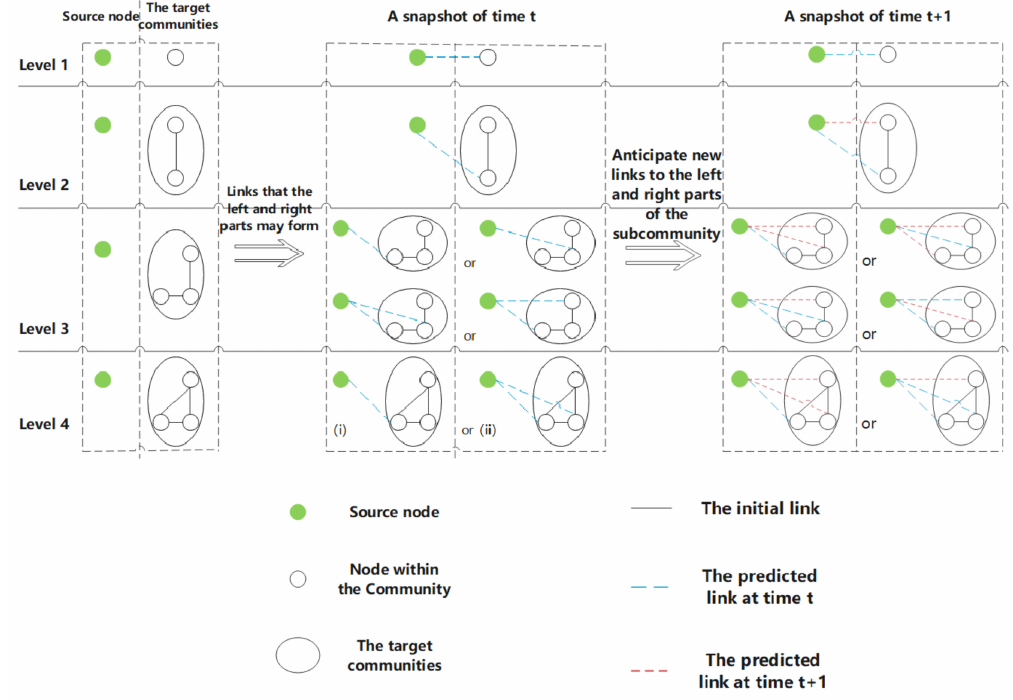
Figure 1. The possible interactions between nodes and communities in an opportunistic social